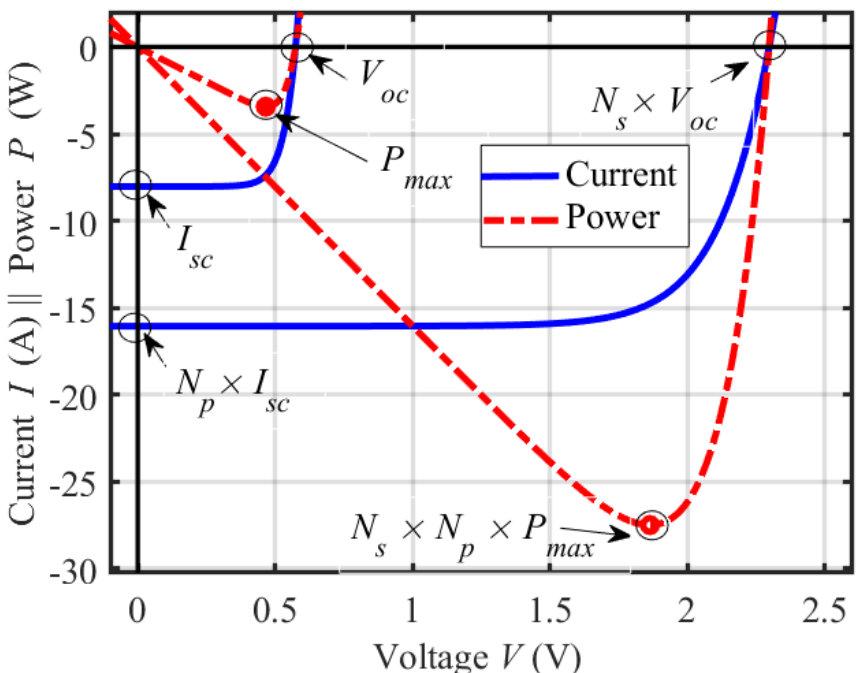
Figure 2. Current and power characteristics of a PV cell and the corresponding module comprising N s series-connected cells and N p parallel-connected